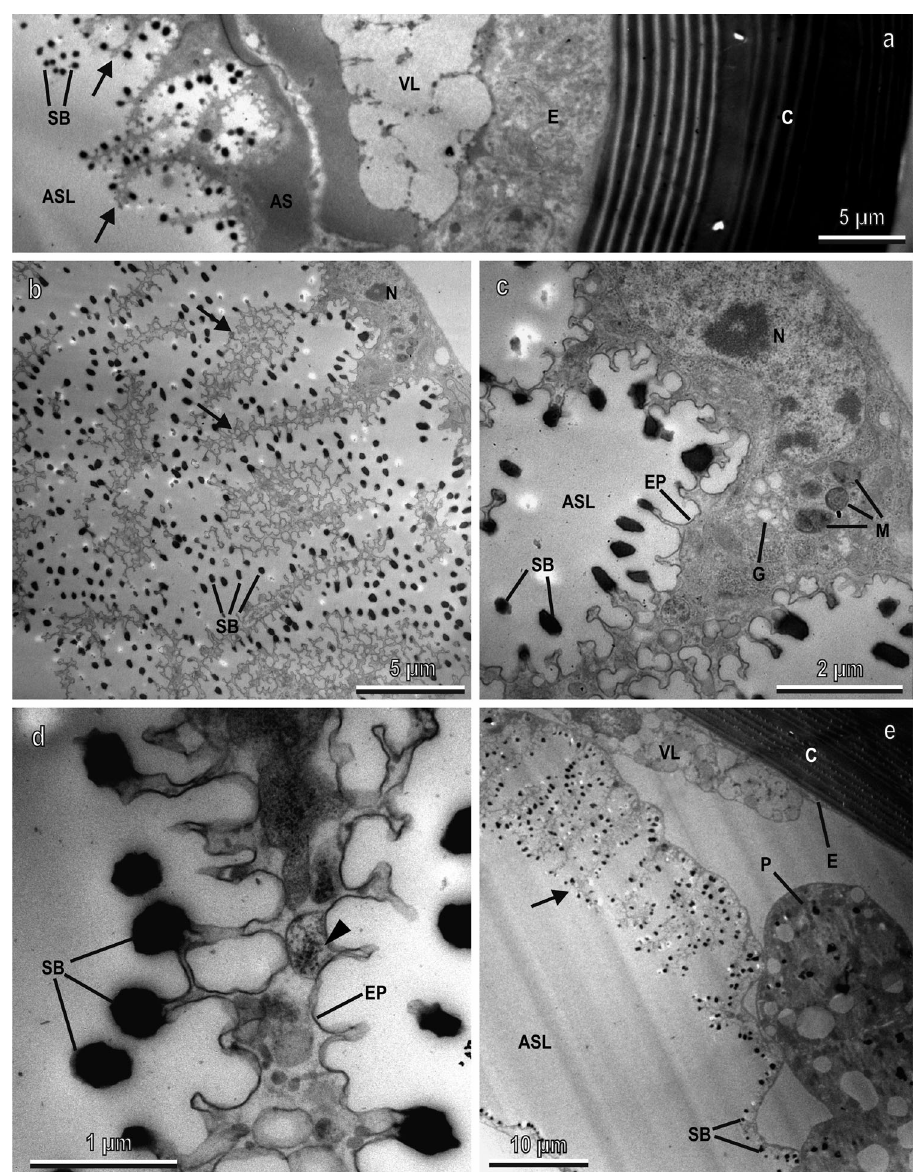
Fig. 5 Longitudinal sections of the scutellum of ten days old adult (female) of Bactrocera oleae visualised with TEM. a General view showing the multi- layered transparent cuticle (C), the epidermis (E), the vesicular layer (VL), and the air sac (AS) constituted of a monolayer of thin cells with arborisations (arrows) bordered by electron-dense spiny beads (SB). ASL air sac lumen; b , c Details of one of the cells of the air sac with its arborisations (arrows) and spiny beads (SB). BL basal lamina, EP epicuticular layer, G Golgi apparatus, M mitochondria, N nucleus; d Detail of one of the arborisations containing granules and vesicles (arrow heads) with very electron-dense spiny beads (SB). Note that the cuticular stems of the beads (arrow) appear thin and elongated. EP epicuticular layer; e View of the scutellum moving far from the dorsal area, showing that the length of arborisations is reduced and only scattered spiny beds (SB) are visible facing the air sac lumen (ASL). Note that the vesicular layer (VL) is visible just over the developed arborisations of the air sacs (arrow). (P). C cuticle, E